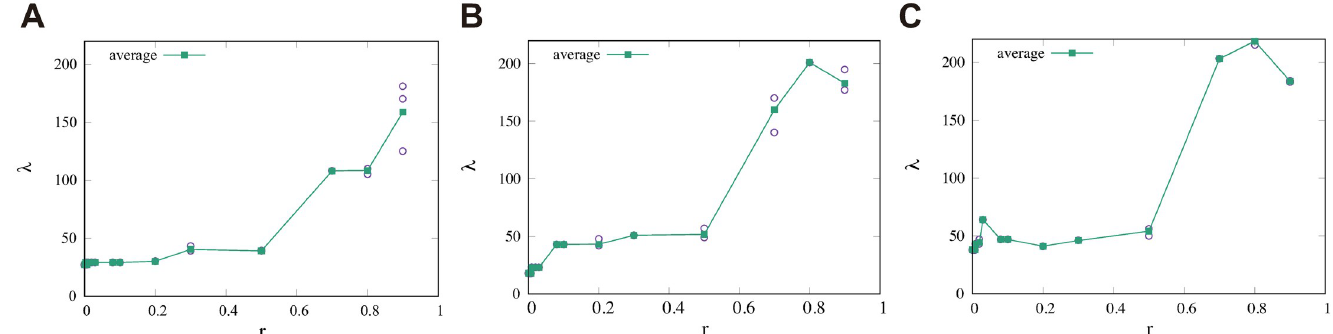
Fig 14. Robustness of penalty against the loss of reads data. The effect of the loss of reads on the global penalty λ . Reads were removed randomly from the uniform distribution with probability r . Then global penalty λ was calculated with parameter M cut = 30000 (A), M cut = 64000 (B) or M cut = 80000 (C). Each circle indicates one sample and each square indicates the average over samples at the same r